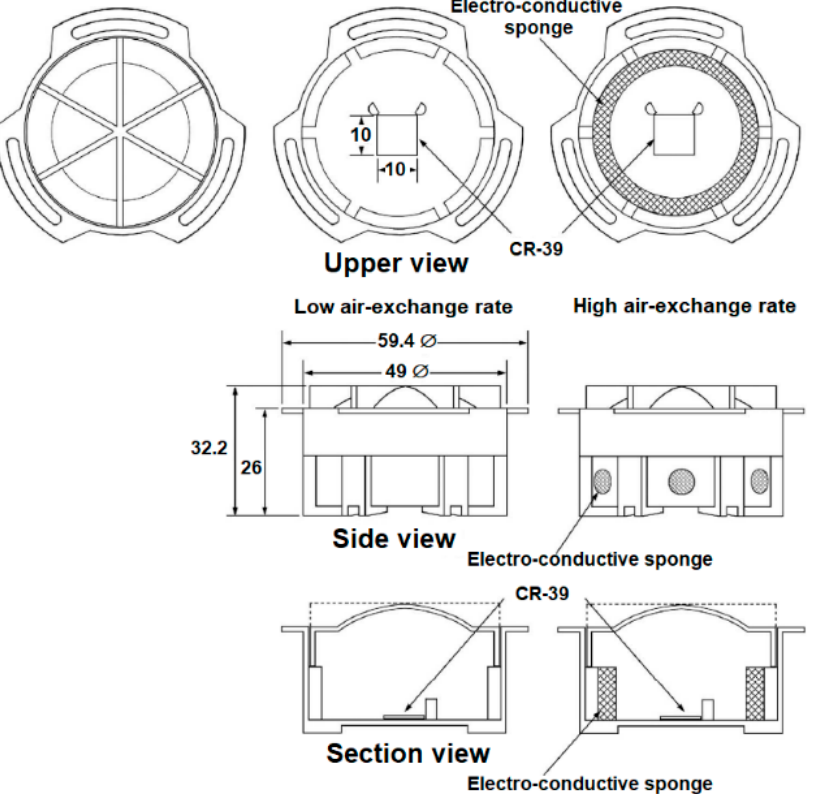
Figure 1. Schematic views of the RADUET monitor (unit: mm).